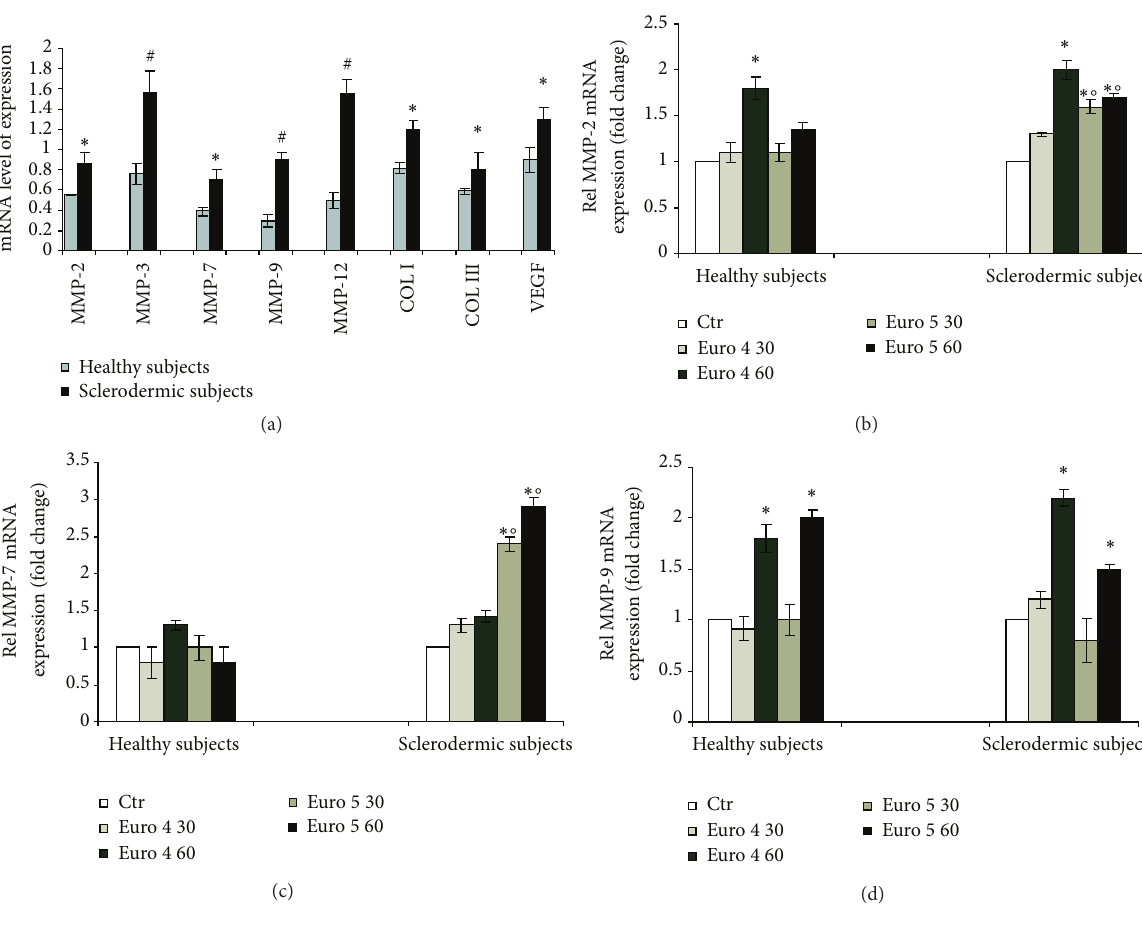
Figure 4: Real time PCR analysis of the expression of MMP-2, MMP-3, MMP-7, MMP-9, and MMP-12, Col I and Col III, and VEGF in primary culture of fibroblasts from sclerodermic and healthy subjects ( ∗ 𝑃 < 0.01 ; # 𝑃 < 0.001 ) (a). Real time PCR analysis of the expression of MMP-2 (b), MMP-7 (c), and MMP-9 (d) in primary culture of fibroblasts from sclerodermic and healthy subjects stimulated with Euro 4 and Euro 5 nanoparticles (30 and 60 𝜇 g/mL) for 6h. ( ∗ 𝑃 < 0.01 versus control; ∘ 𝑃 < 0.01 versus healthy